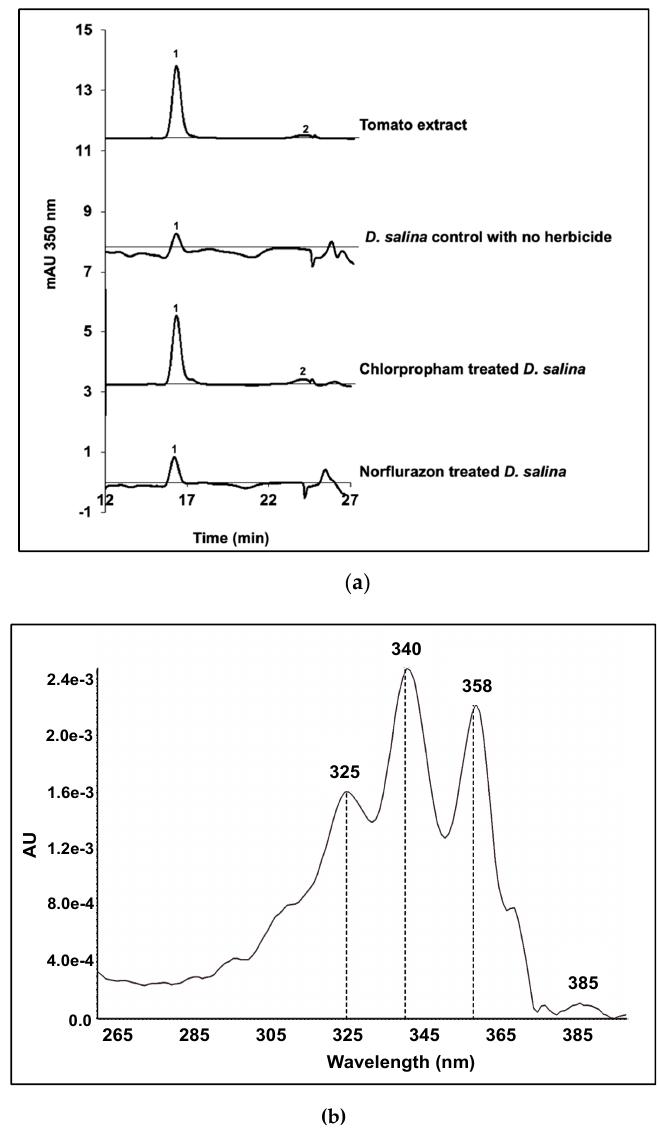
Figure 9. ( a ) HPLC analysis of phytofluene isomers extracted from ripe tomatoes, control D. salina cultures with no herbicide, D. salina cultures treated with 20 µ M chlorpropham, and D. salina cultures treated with 5 µ M norflurazon, only showing the region of interest in the chromatogram and ( b ) absorption spectrum of phytofluene in Methanol / MTBE (8 / 2) obtained from UPC 2 .